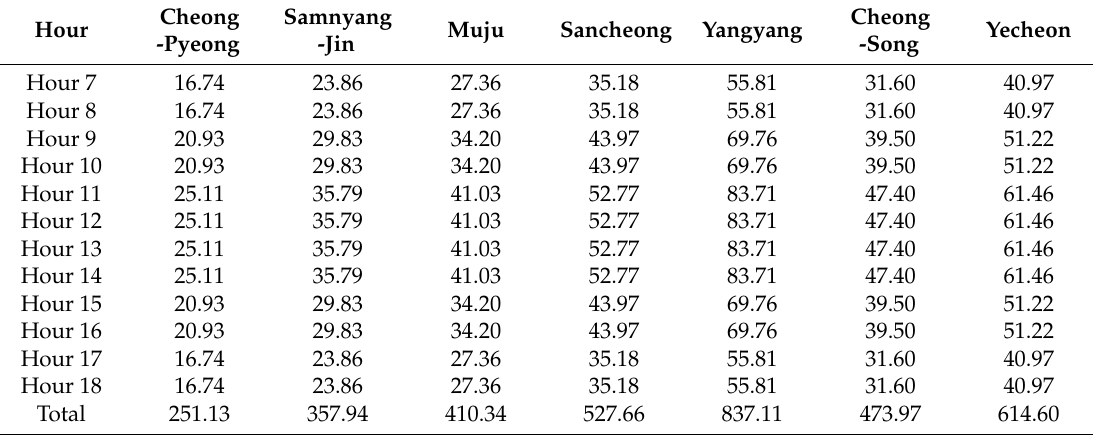
Table 4. PHES hourly reserve capacity. 10% of the maximum available energy is allocated based on the proposed method (unit: